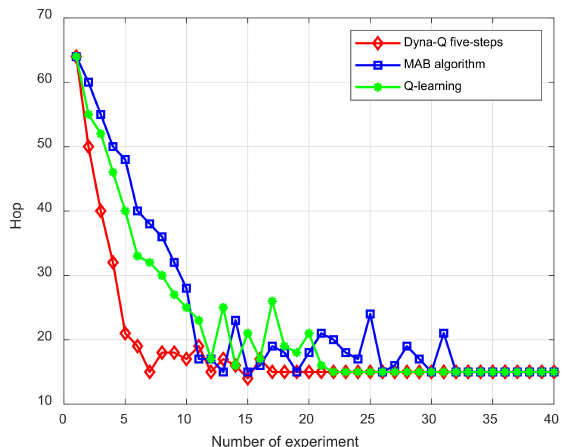
Figure 6. Comparison of hops required by different algorithms in each